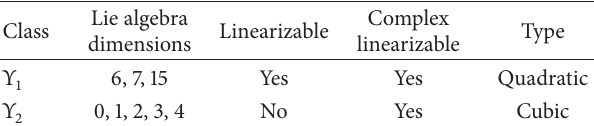
Table 1: Classificationof two-dimensional systems arising from linear complex